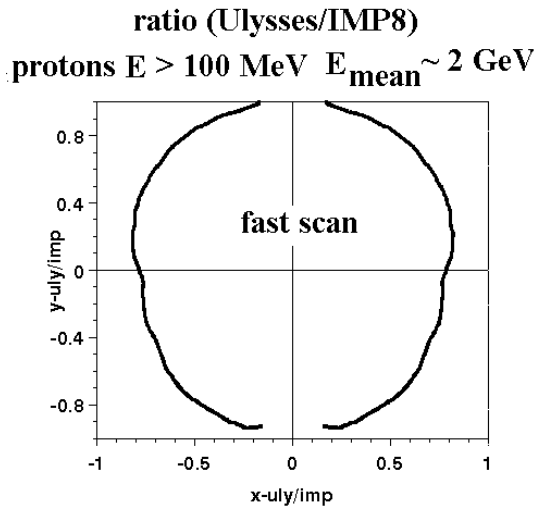
Fig. 3a. The Ullysses cosmic-ray heliolatitudinal variation;